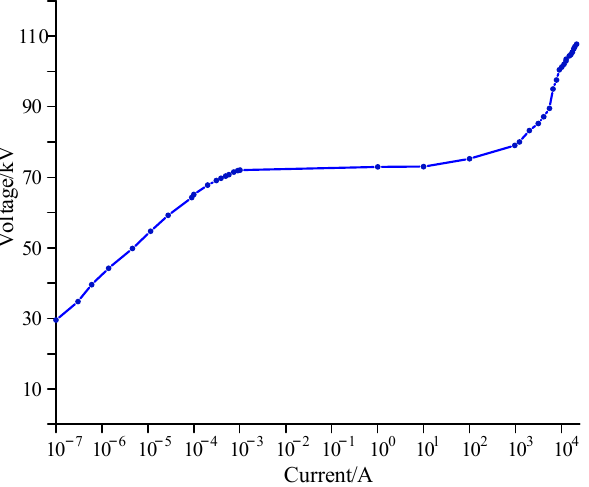
Figure 11. Volt-ampere characteristics of the arrester.